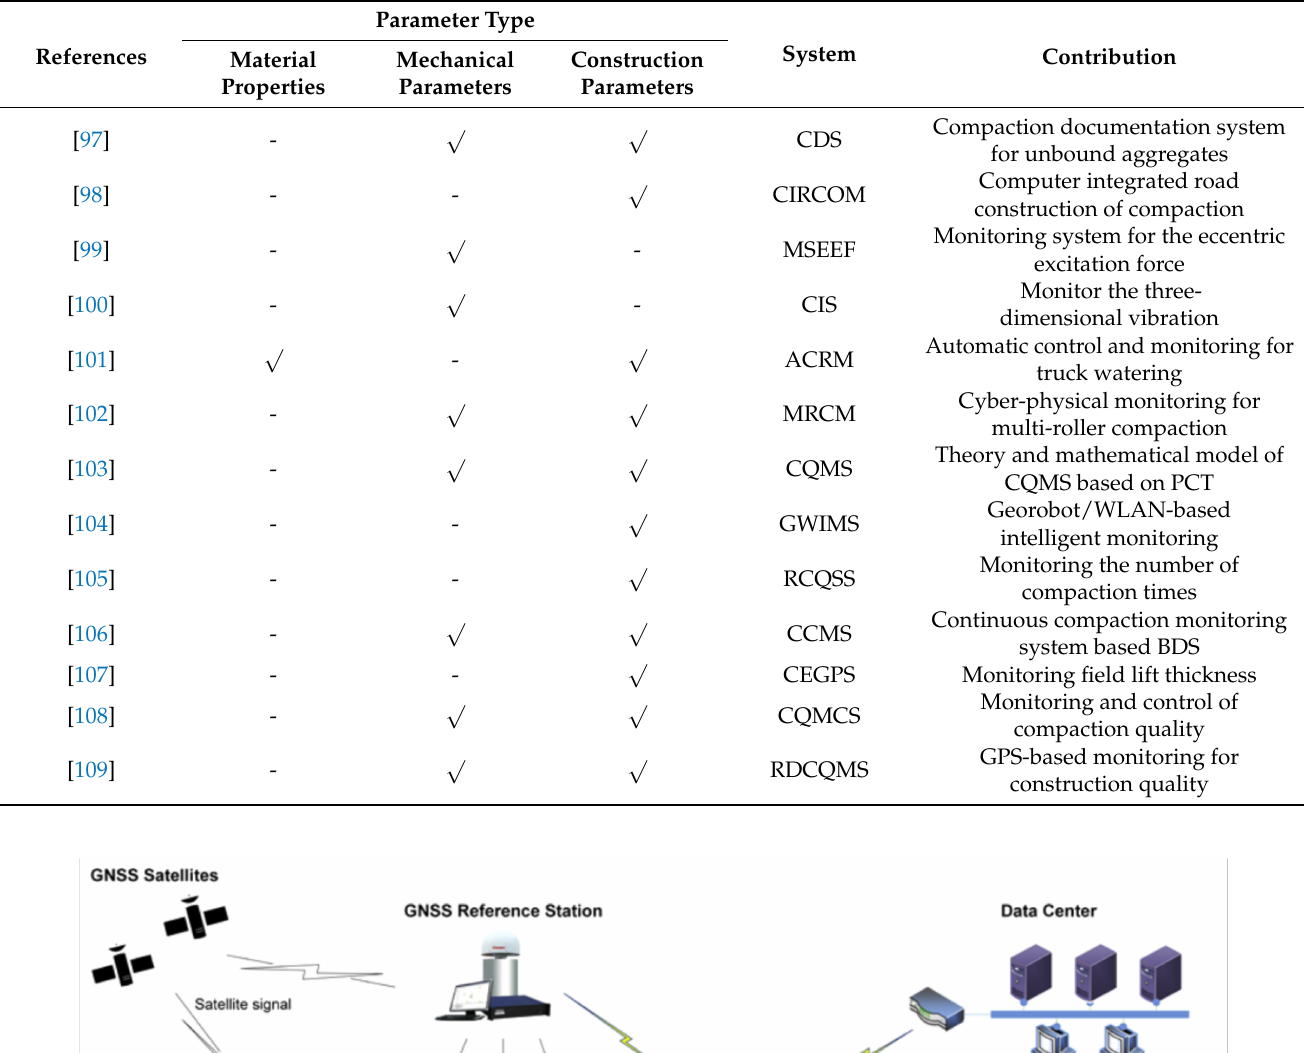
Table 1. Related work contributions and comparison (